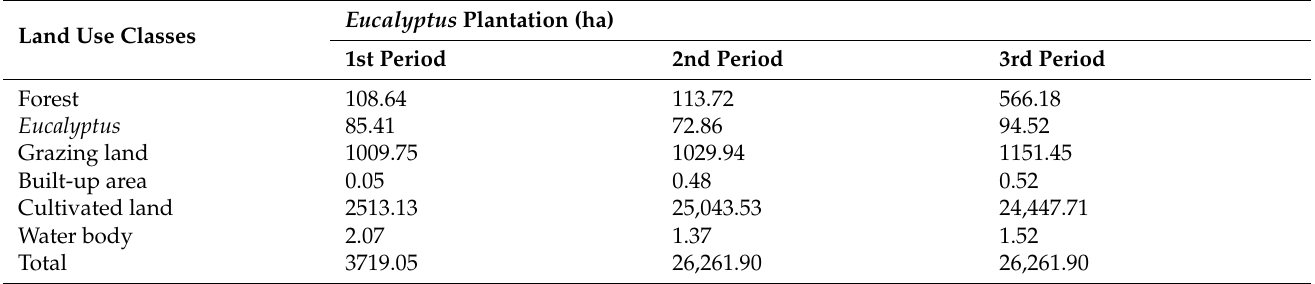
Table 6. The spatial conversions of different land use towards Eucalyptus